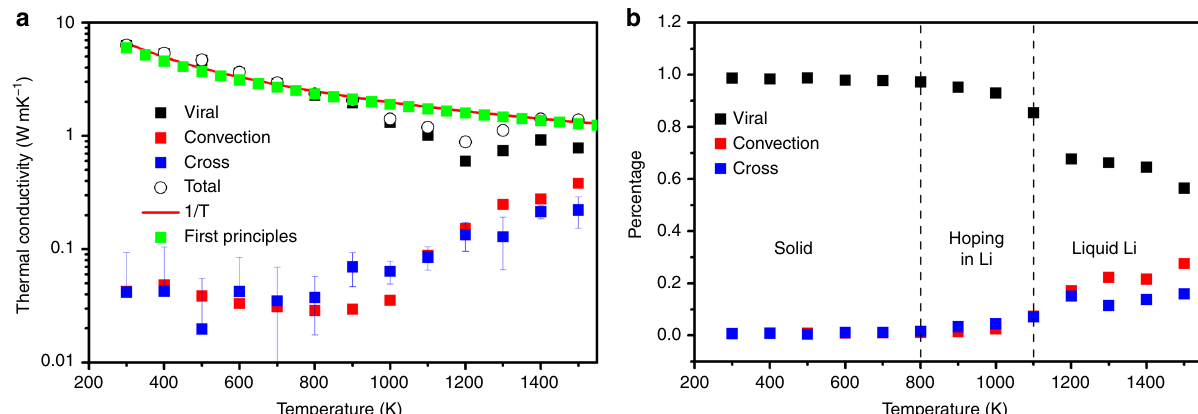
Fig. 2 Contributions to temperature dependent thermal conductivity. a Total thermal conductivity (TC) and its contributions from the virial, the convection and the cross terms computed using Green-Kubo equilibrium molecular dynamics (GK-EMD) simulations as well as the comparison of the total TC obtained from GK-EMD and Boltzmann transport equation (BTE); b TC contribution % from the corresponding terms as a function